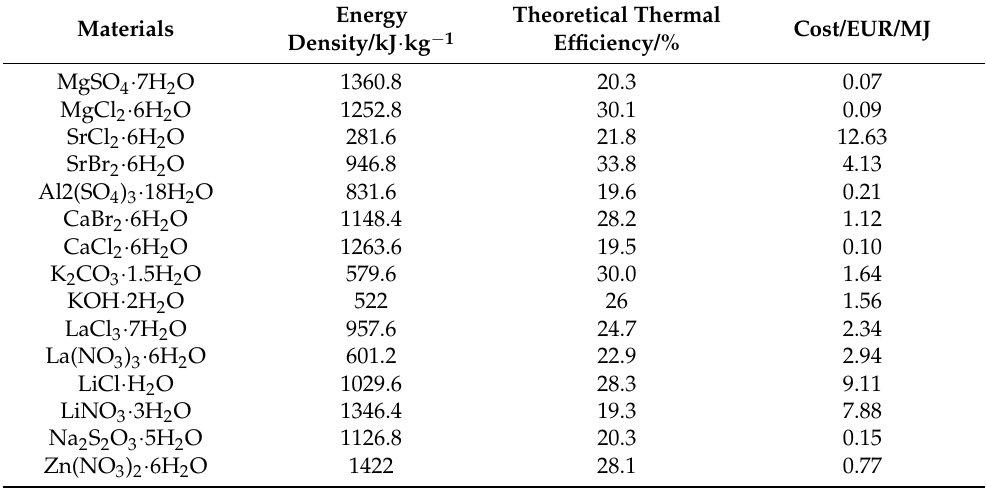
Table 8. Performance of salt hydrate adsorption materials for thermochemical energy storage [48]. Energy Theoretical Thermal Materials Density/kJ · kg − 1